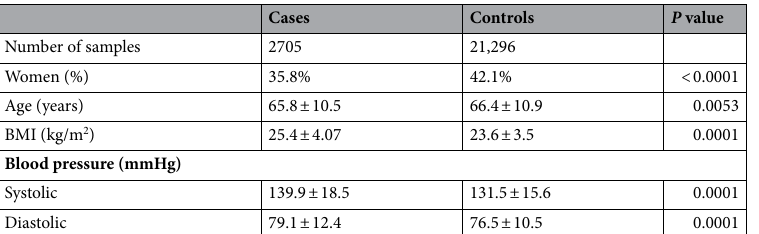
Table 2. Baseline demographics of study population. BMI body mass index; SD standard deviation. Data at enrollment are summarized. Data are mean ± SD unless otherwise stated. Comparisons of patient demographics between cohorts were performed using Welch’s t test for continuous variables and chi-squared test for categorical